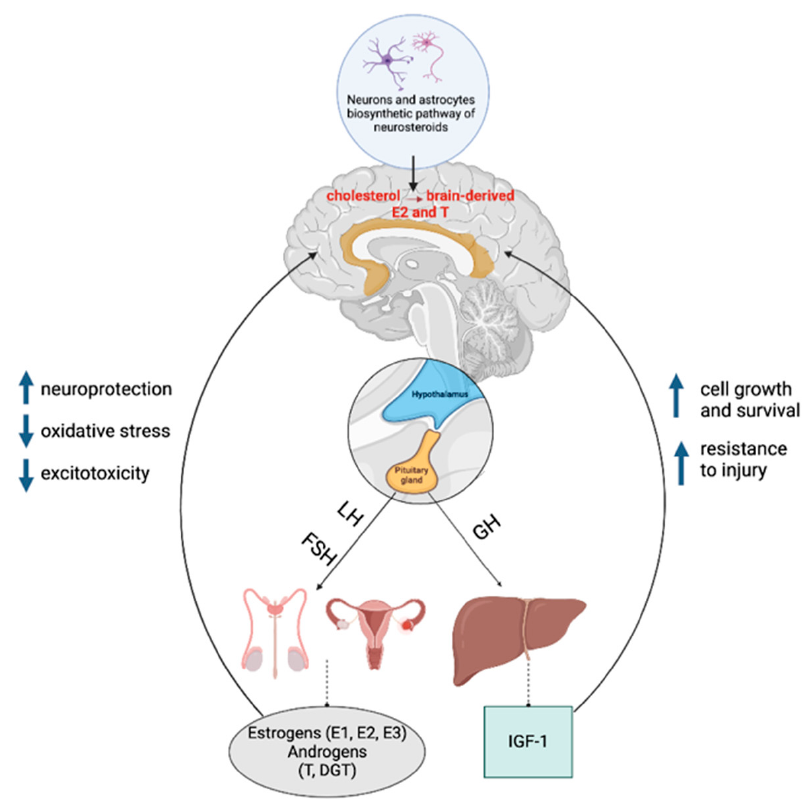
Figure 4. General scheme of production and effects of sex hormones and IGF-1 on the brain (LH—luteinizing hormone; FSH—follicle-stimulating hormone; GH—growth hormone; IGF-1—insulin-like growth factor 1; E1—estrone; E2—estradiol; E3—estriol; T—testosterone; DGT—dihydrotestosterone). Created with